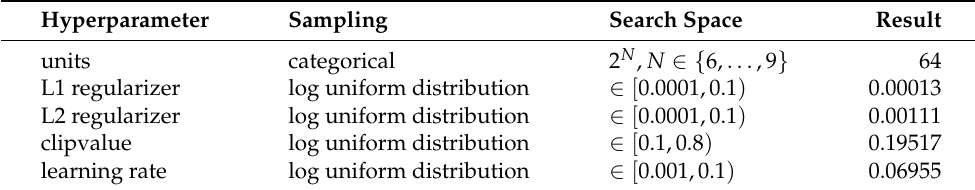
Table 5. Hyperparameters, search space and optimization results for the LSTM